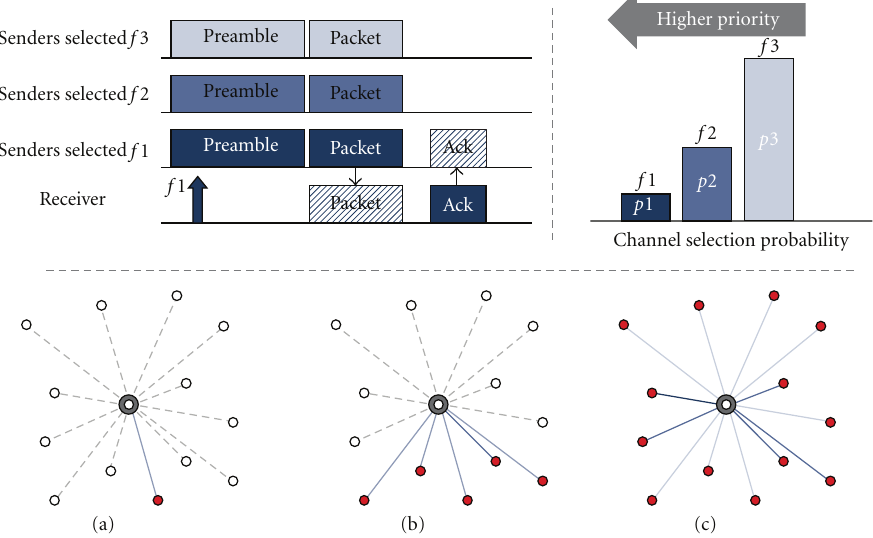
Figure 3: Alert protocol illustration. (a) If there is only one sender, it does not matter which channel it picks. (b) With 5 nodes sending, with high probability only one picks the second channel. (c) With many senders, one is very likely to pick the first channel and succeed.